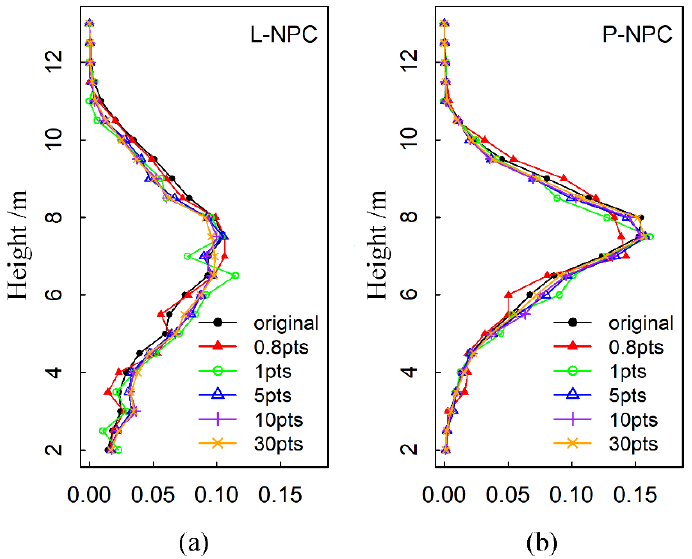
Figure 5. An example of the vertical distribution curves of thinned datasets with 0.8, 1, 5, 10, and 30 pts/m 2 and original point cloud density data from ULS ( a ) and USP ( b ) at plot YD11-1Y.